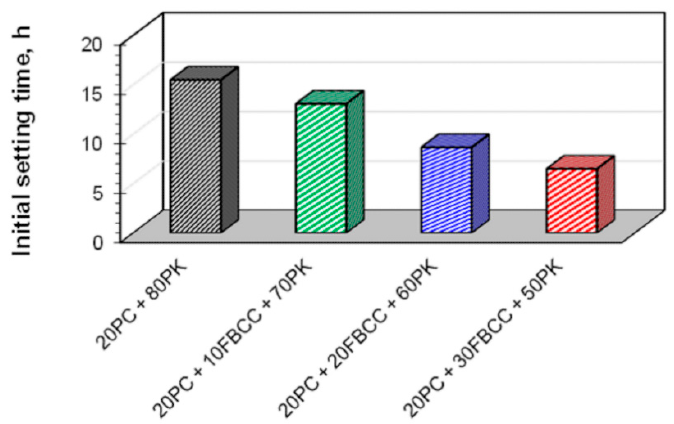
Figure 2. Initial setting time for blended four-component binders.